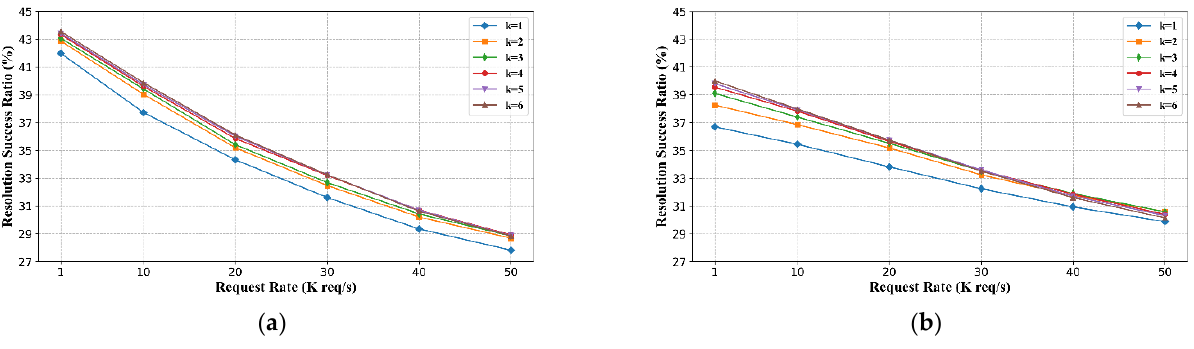
Figure 8. Name resolution success rate with different parameter k . ( a ) Name resolution success rate of the DP strategy. ( b ) Name resolution success rate of the RN strategy.